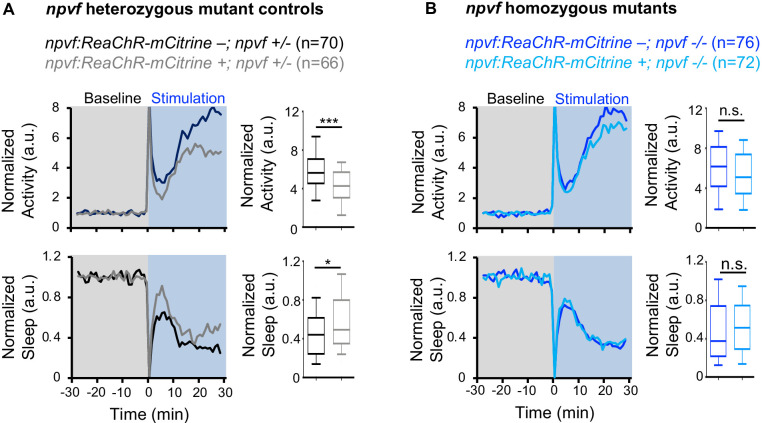
Sleep induced by optogenetic stimulation of NPVF neurons is abolished in npvf mutant animals.Normalized locomotor activity (top) and sleep (bottom) of 5-dpf Tg(npvf:ReaChR-mCitrine) (gray and light blue) and non-transgenic sibling control (black and blue) animals before (Baseline) and during exposure to blue light (Stimulation) in npvf +/- (A) and npvf -/- (B) animals. Box plots quantify locomotor activity and sleep for each animal during optogenetic stimulation normalized to the baseline of all animals of the same genotype. Stimulation of NPVF neurons decreases locomotor activity and increases sleep compared to non-transgenic sibling controls in npvf +/- animals (A) but not in npvf -/- siblings (B). n = number of animals. ns p>0.05, *p<0.05, ***p<0.005, Mann-Whitney test.